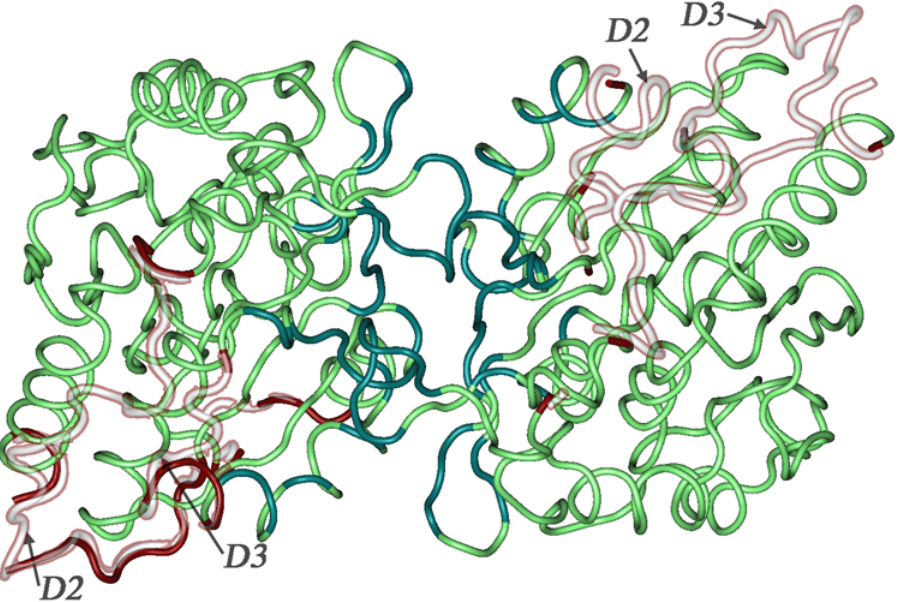
Figure 4. Disordered regions displayed in the homodimeric complex of heat shock protein hsp31 (1PV2). The structured regions of 1PV2 are shown in green with interface residues highlighted in teal. A trace of possible order in the disordered regions was drawn using the 1ONS structure (the same protein in its monomeric state without disorder) which was structurally superimposed on 1PV2 two times, once for each half of the homodimer. Residues capping disordered regions in the homodimer are colored in red and the corresponding ordered residues from the monomer are drawn as silhouettes. A few additional residues of 1ONS in the left monomer are ordered compared to the same residues on the right and therefore are also colored red.